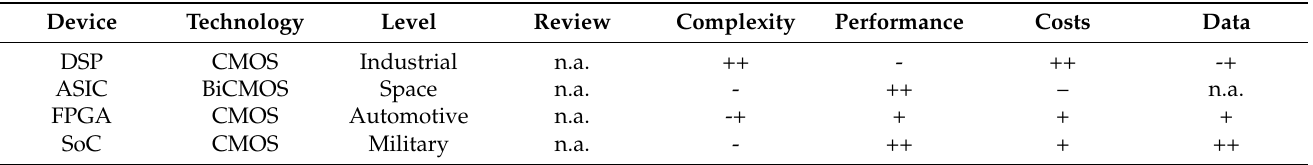
Table 6. Technology assessment for the signal-processing